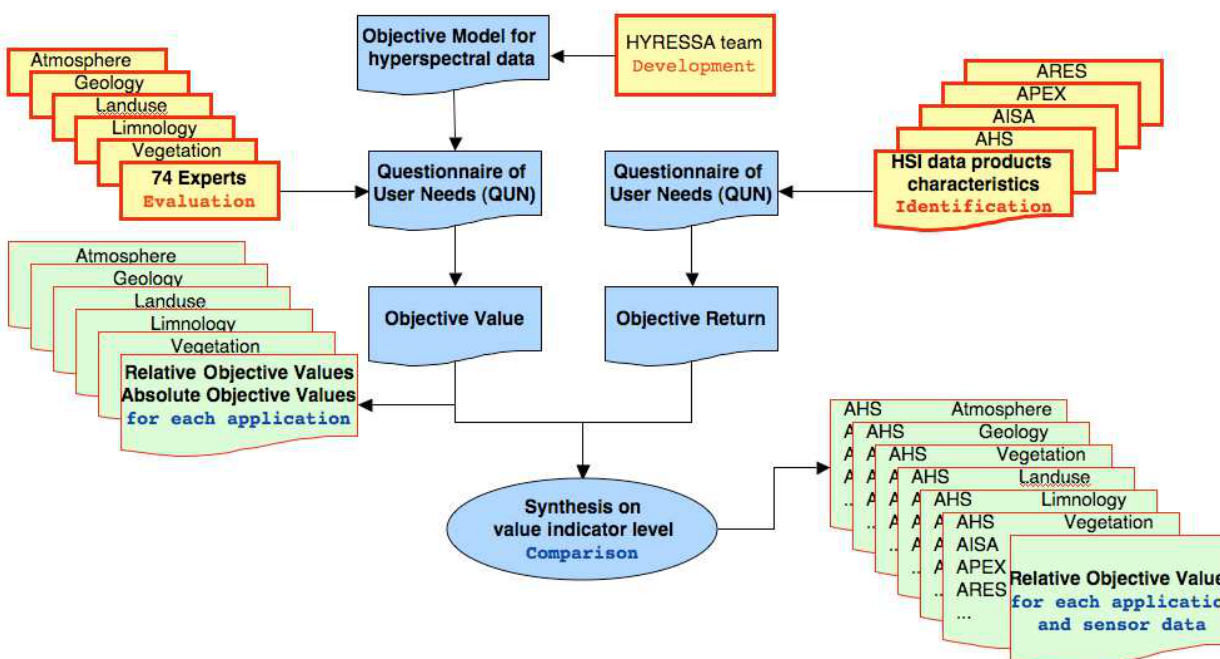
Figure 1. The methodology of Value-Benefit Analysis (VBA) applied on hyperspectral